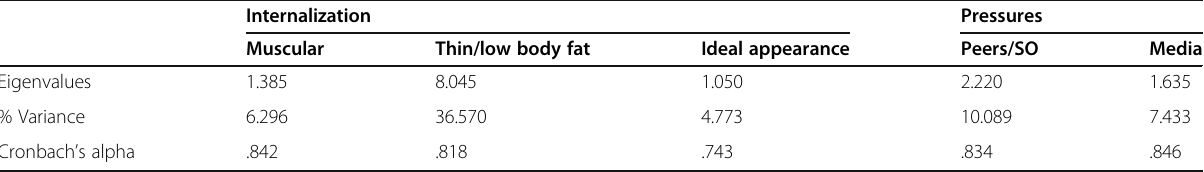
Table 2 EFA indicators from the solution of five factors for